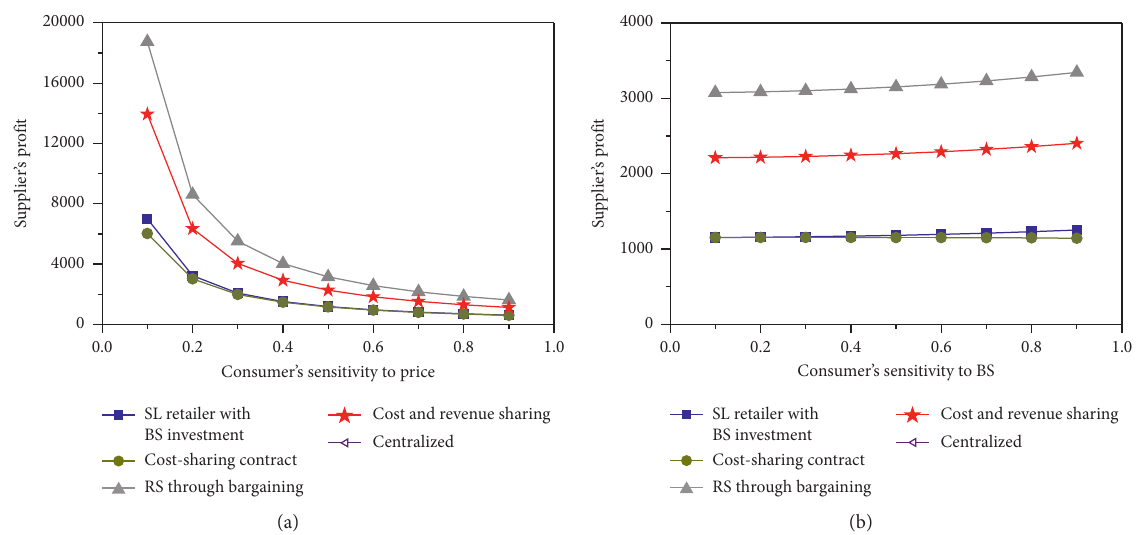
Figure 3: (a) The effect of optimal b on the expected profits of the suppliers. (b) The effect of optimal β on the expected profits of the